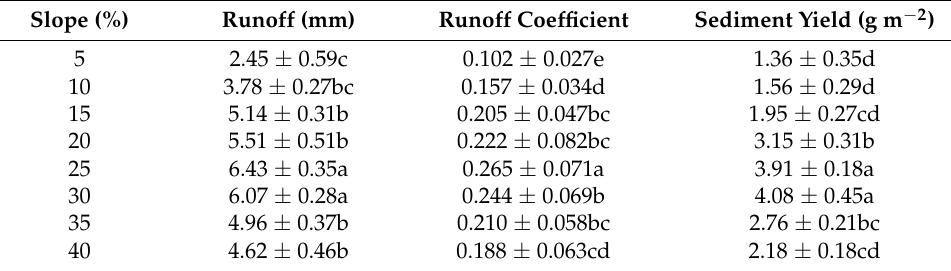
Table 5. Mean ( ± sd. Error) of runoff, runoff coefficient, and sediment yield on different slope gradient of plot (i.e., 5, 10, 15, 20, 25, 30, 35, and